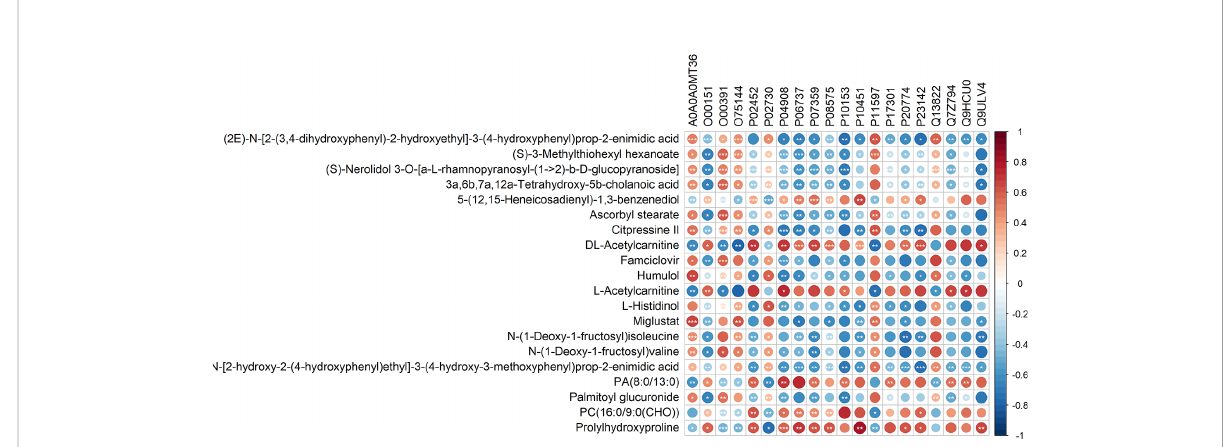
FIGURE 8 Correlation analysis of the differential proteins and metabolites. In the fi gure, red is positively correlated and blue is negatively correlated. *** represents correlation p value less than 0.001, ** represents correlation p value less than 0.01, and * represents correlation p value less than